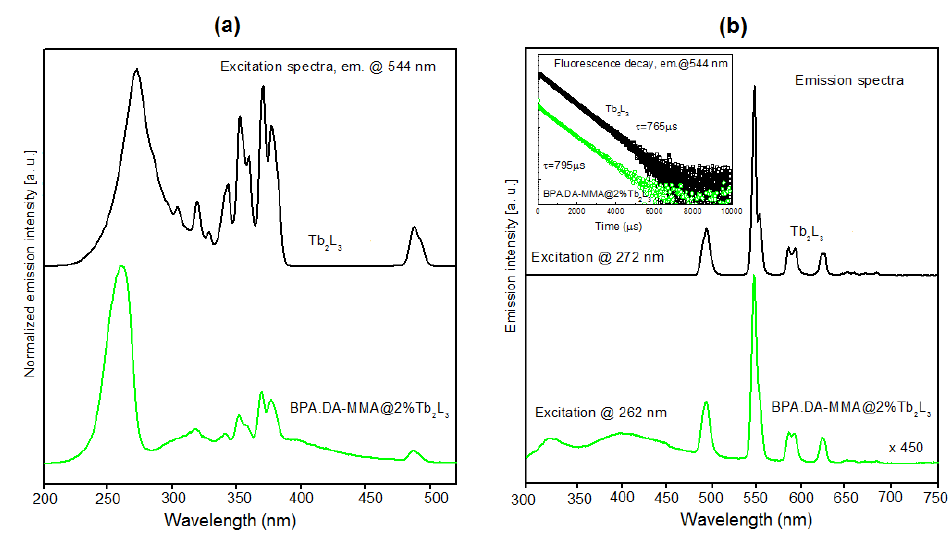
Figure 8. ( a ) Comparison of the excitation characteristics recorded for the Tb 2 L 3 complex and the BPA.DA-MMA@2%Tb 2 L 3 hybrid material (544 nm emission). ( b ) Comparison of the emission characteristics recorded for the Tb 2 L 3 complex and the BPA.DA-MMA@2%Tb 2 L 3 hybrid material (UV excitation).